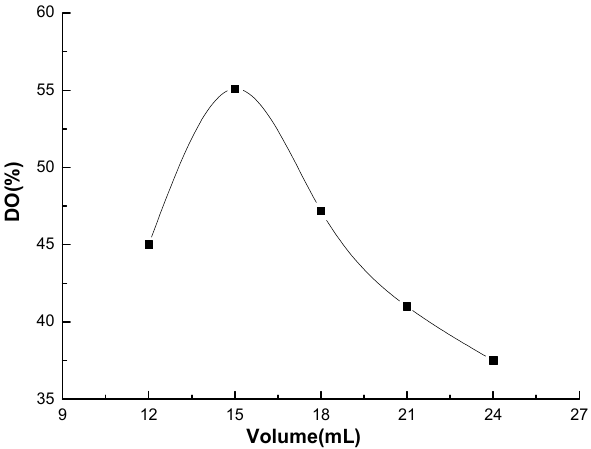
Figure 2. The e ff ects of the total acid volume of HNO 3 / H 3 PO 4 –NaNO 2 mediated oxidation system on Figure 2. The effects of the total acid volume of HNO 3 /H 3 PO 4 –NaNO 2 mediated oxidation system on the oxidation degree of the oxidation degree of chitosan.